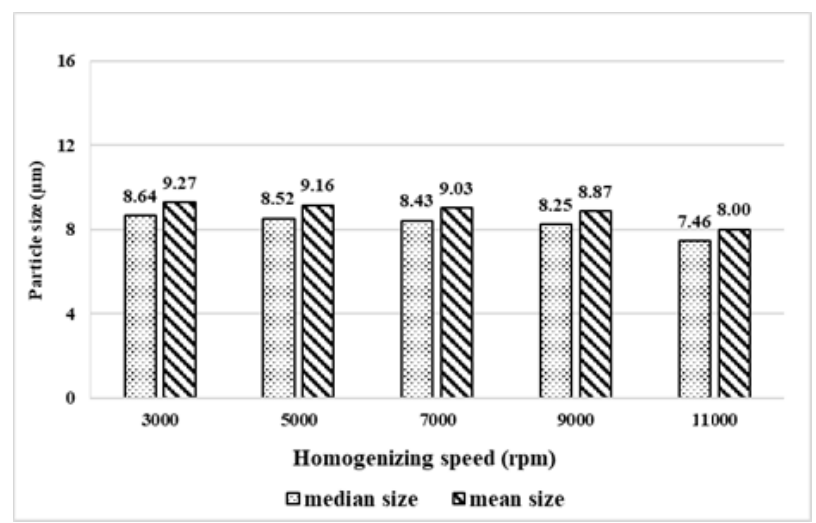
Figure 2. Effect of different homogenization speeds on particle size of suspensions. Figure 2. E ff ect of di ff erent homogenization speeds on particle size of suspensions.